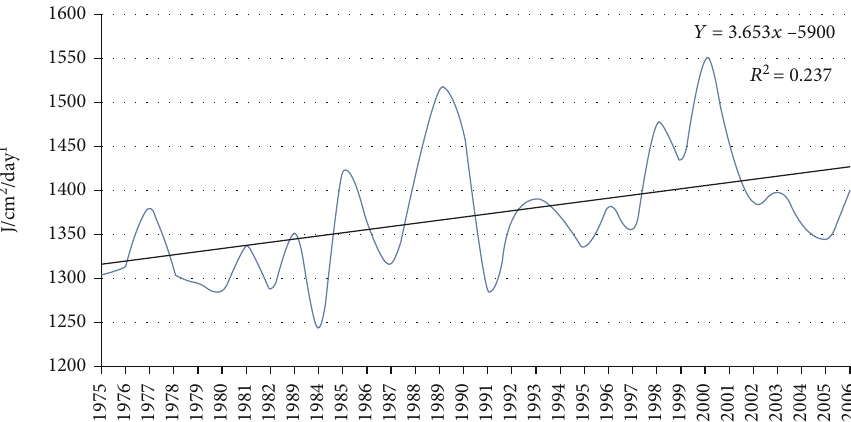
Figure 12: Multiannual variation of solar radiation in Bucharest during